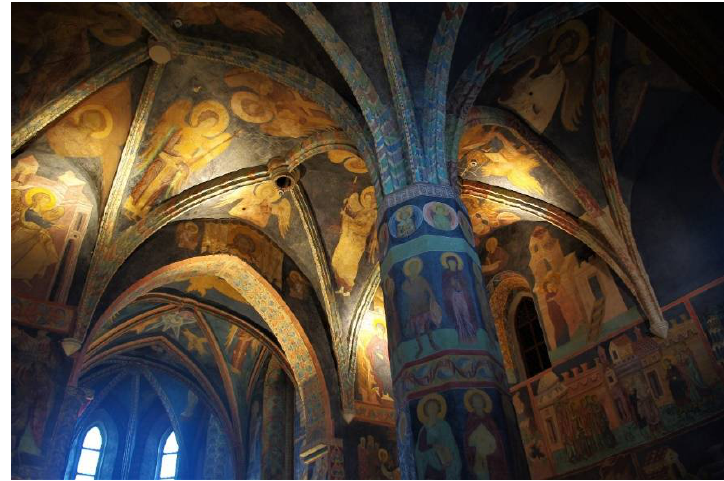
Figure 12. Lublin, castle. Byzantine–Ruthenian frescoes in the castle chapel. 2nd decade of the 15th century. Photo by Tomasz Ratajczak, the author’s own work.